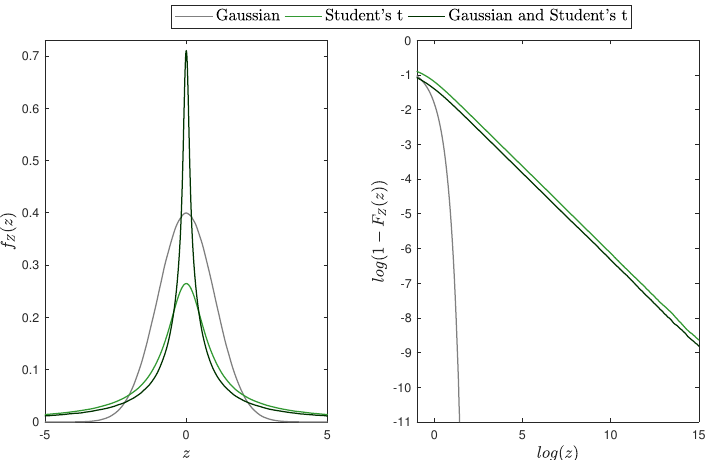
Figure 8. ( Left panel ): the PDF of the random variables X (Gaussian), Y (Student’s t ) and Z . ( Right panel ): the distribution tail’s for X , Y and Z . The parameters are equal to: µ X = 0 and σ X = 1 and n Y =